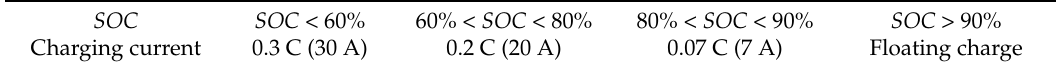
Table 1. Relationship of the charging current and SOC